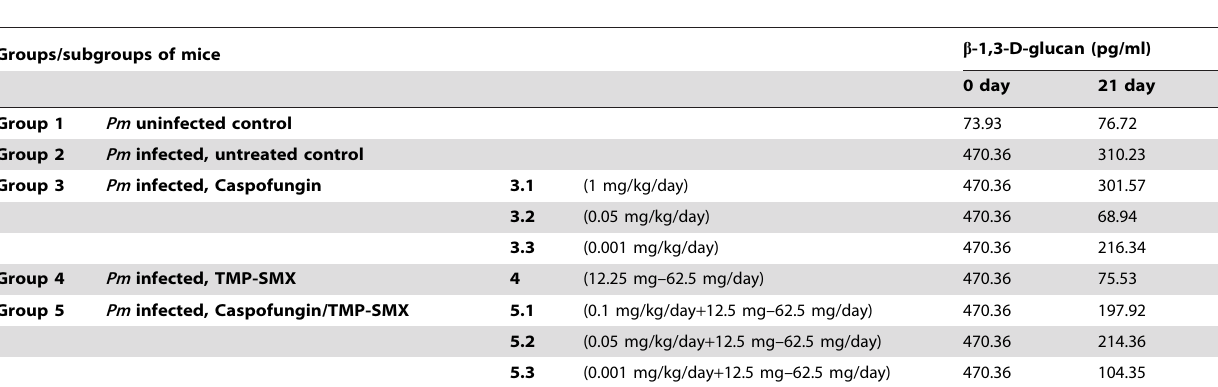
Table 2. Results of serum BG levels from mice enrolled in the study.